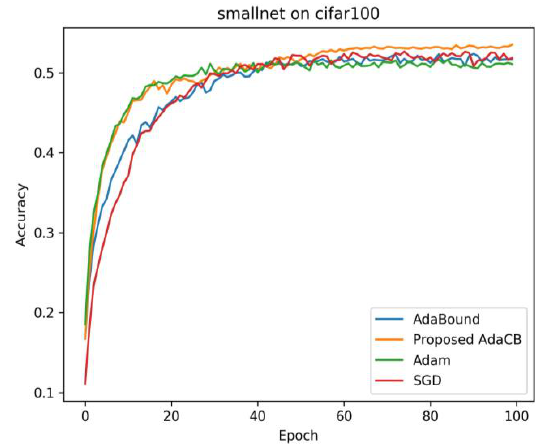
Figure 2. The learning curve of testing accuracy on CIFAR10 under Smallnet.